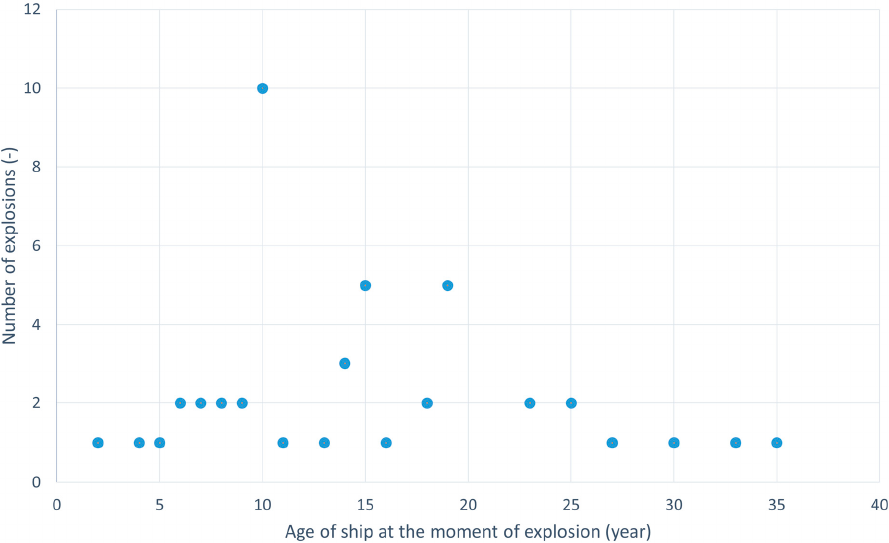
Figure 9. Number of main engine turbocharger explosions as a function of the ship’s age.